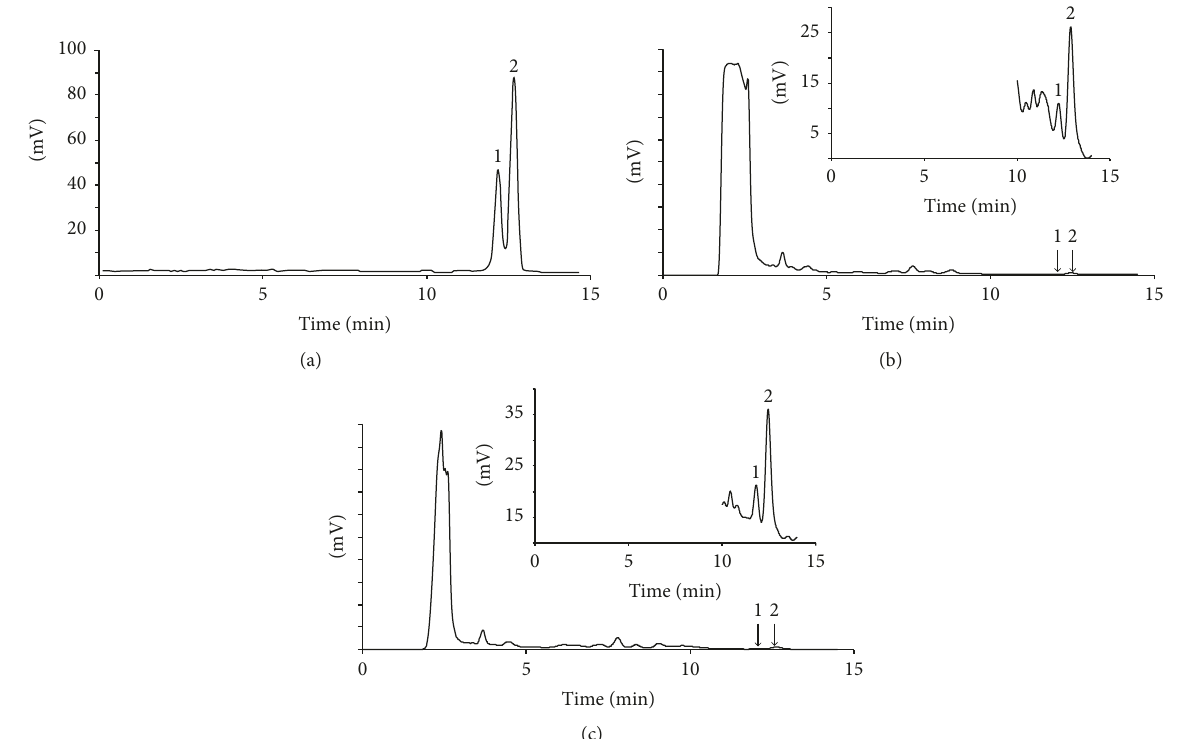
Figure 3: HPLC chromatograms of standard solutions of UA and OA (a), a blank guava leaf sample (b), and a guava leaf sample after QuEChERS-based extraction (c). The embedded graphs are the magnified view of the chromatograms. Peaks in the chromatogram: (1) OA, (2) UA.